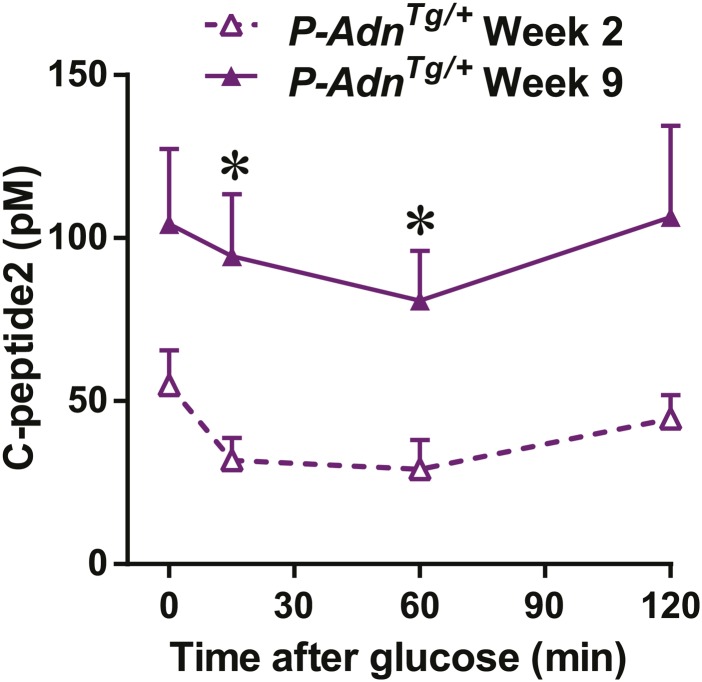
Adiponectin enhances in vivo GSIS in PANIC-ATTAC mice.Plasma C-peptide2 levels during oral glucose tolerance tests. Data are presented as the mean ± SEM. *p < 0.05. Related to Figure 7C,D.